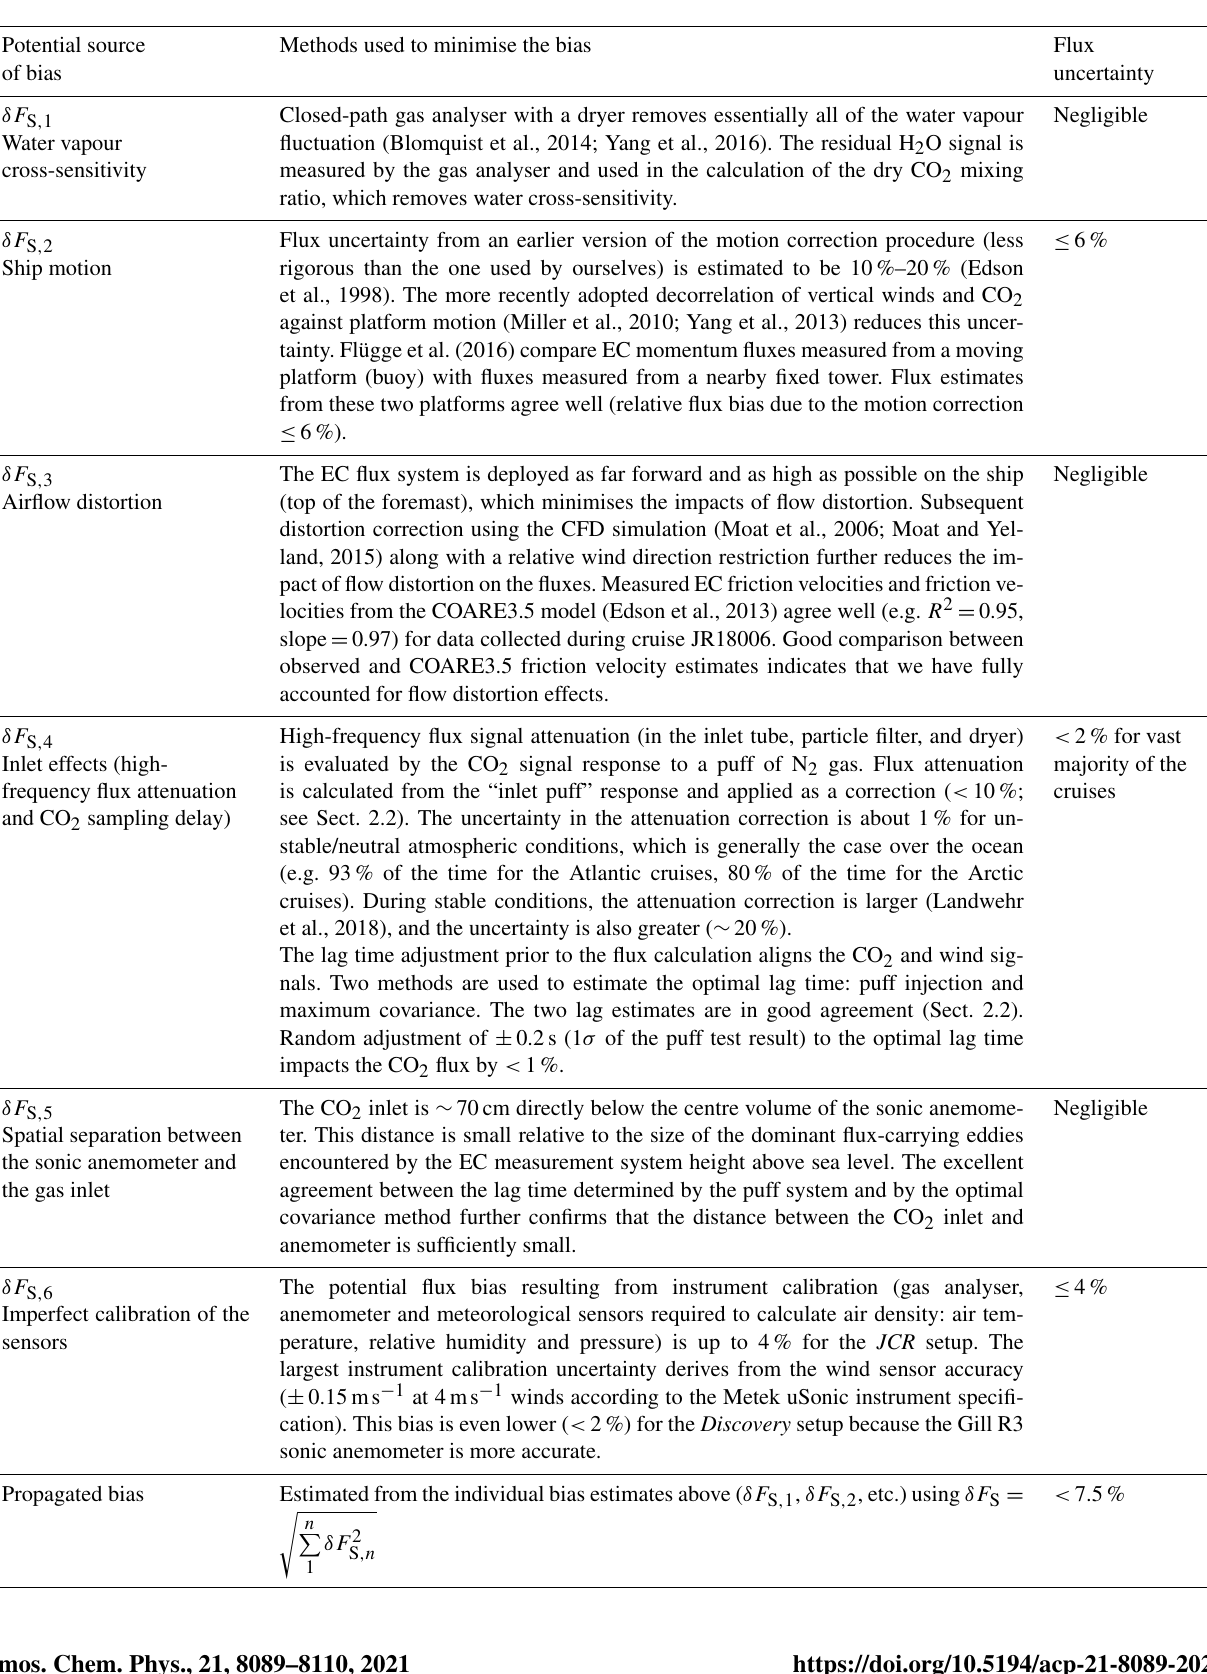
Table 2. Potential sources of bias in our EC air–sea CO 2 flux measurements and the methods used to minimise them. Potential